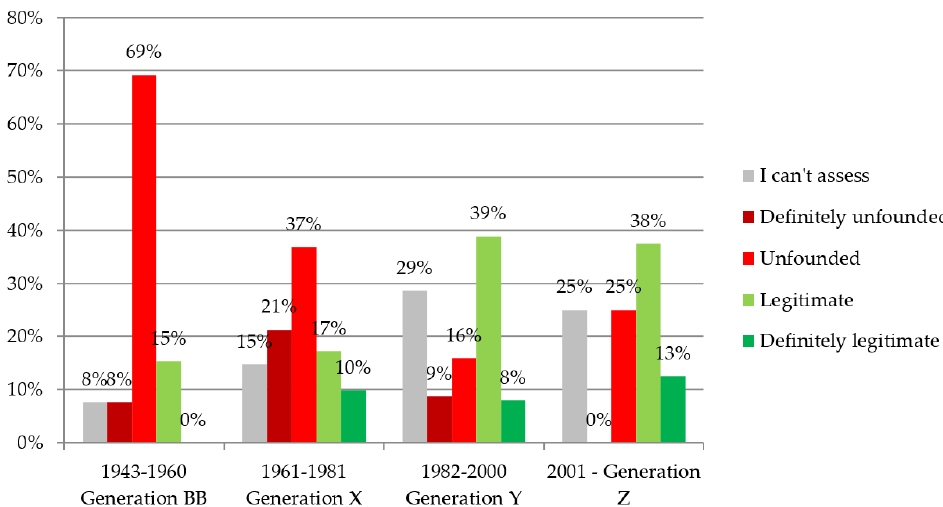
Figure 10. Age and the assessment of the legitimacy of centralization of funds for decarbonization from the perspective of its effectiveness. Source: Own study based on the conducted research, n = 444.